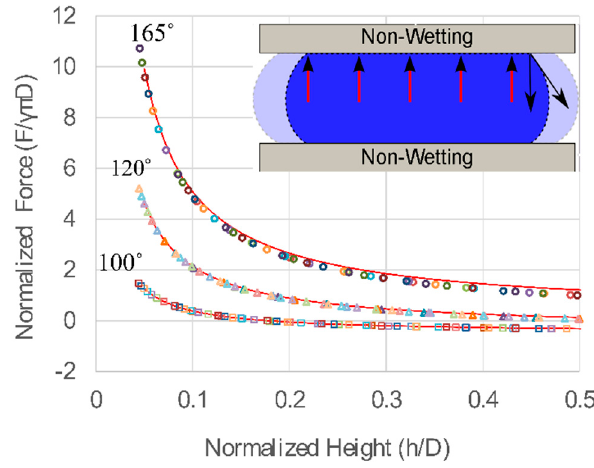
Figure 4. Normalized force vs. normalized height, type 1. For a symmetric capillary bridge on a non- wetting surface, the contact angles are the same top and bottom, circular, triangle and square marks are the simulation results for contact angles of 165°, 120 ° and 100°, respectively. Each data set includes simulation results for 10 droplet volumes used (5–50 µL). The solid lines are the calculated values from Equation (6).